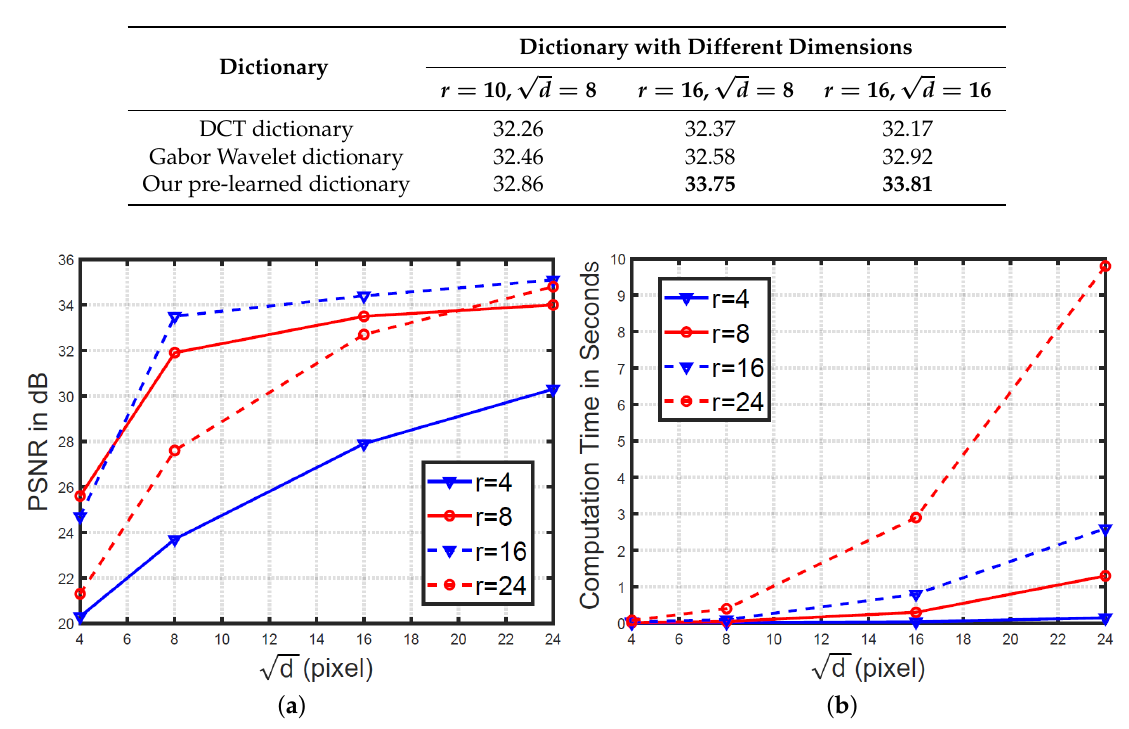
Table 2. Denoising results (peak signal-to-noise ratio (PSNR) value) using different dictionaries (unit: dB).